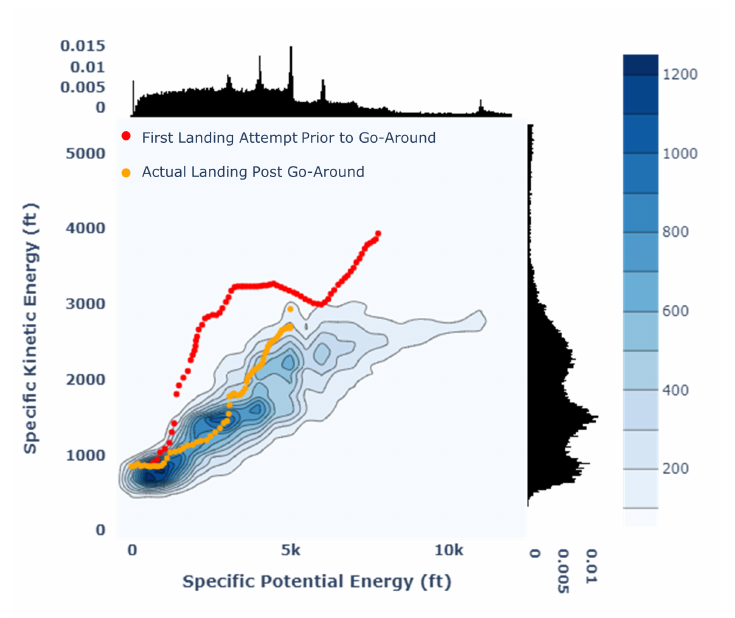
Figure 12. Two-dimensional density contour plot of specific potential energy and specific kinetic energy for all nominal flights. Overlay points are for one select anomalous flight with high energy state. Red points correspond to the initial approach prior to the go-around and orange points correspond to the second approach following the